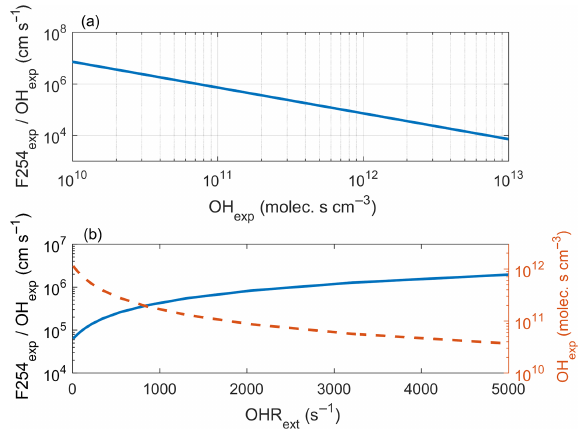
Figure 6. The ratio of 254nm photon flux to OH exposure as a function of OH exposure (a) and external OH reactivity, when the initial ozone concentration is 45ppm, relative humidity is 30% and temperature is 20 ◦ C (b). In (b) , the OH exposure dependence on OH reactivity is also shown at same